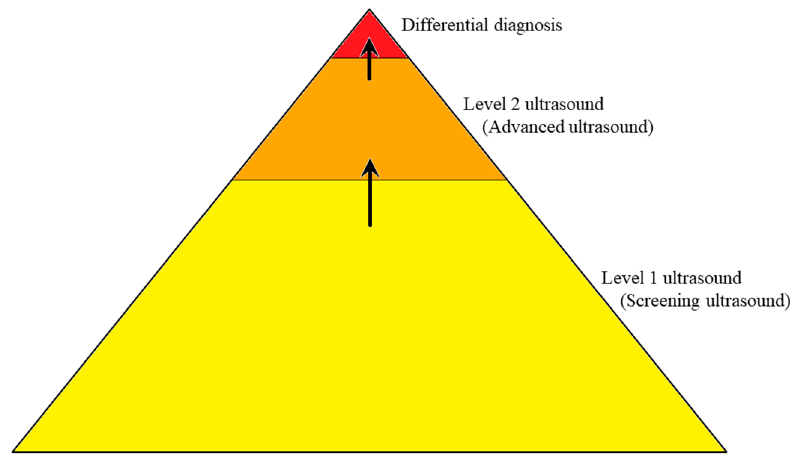
Figure 1. A pyramid chart that represents the distribution of ultrasound scans for endometriosis according to complexity. Although differential diagnosis must be considered in each exam, the number of cases where it makes a difference is relatively small, although it is fundamental.